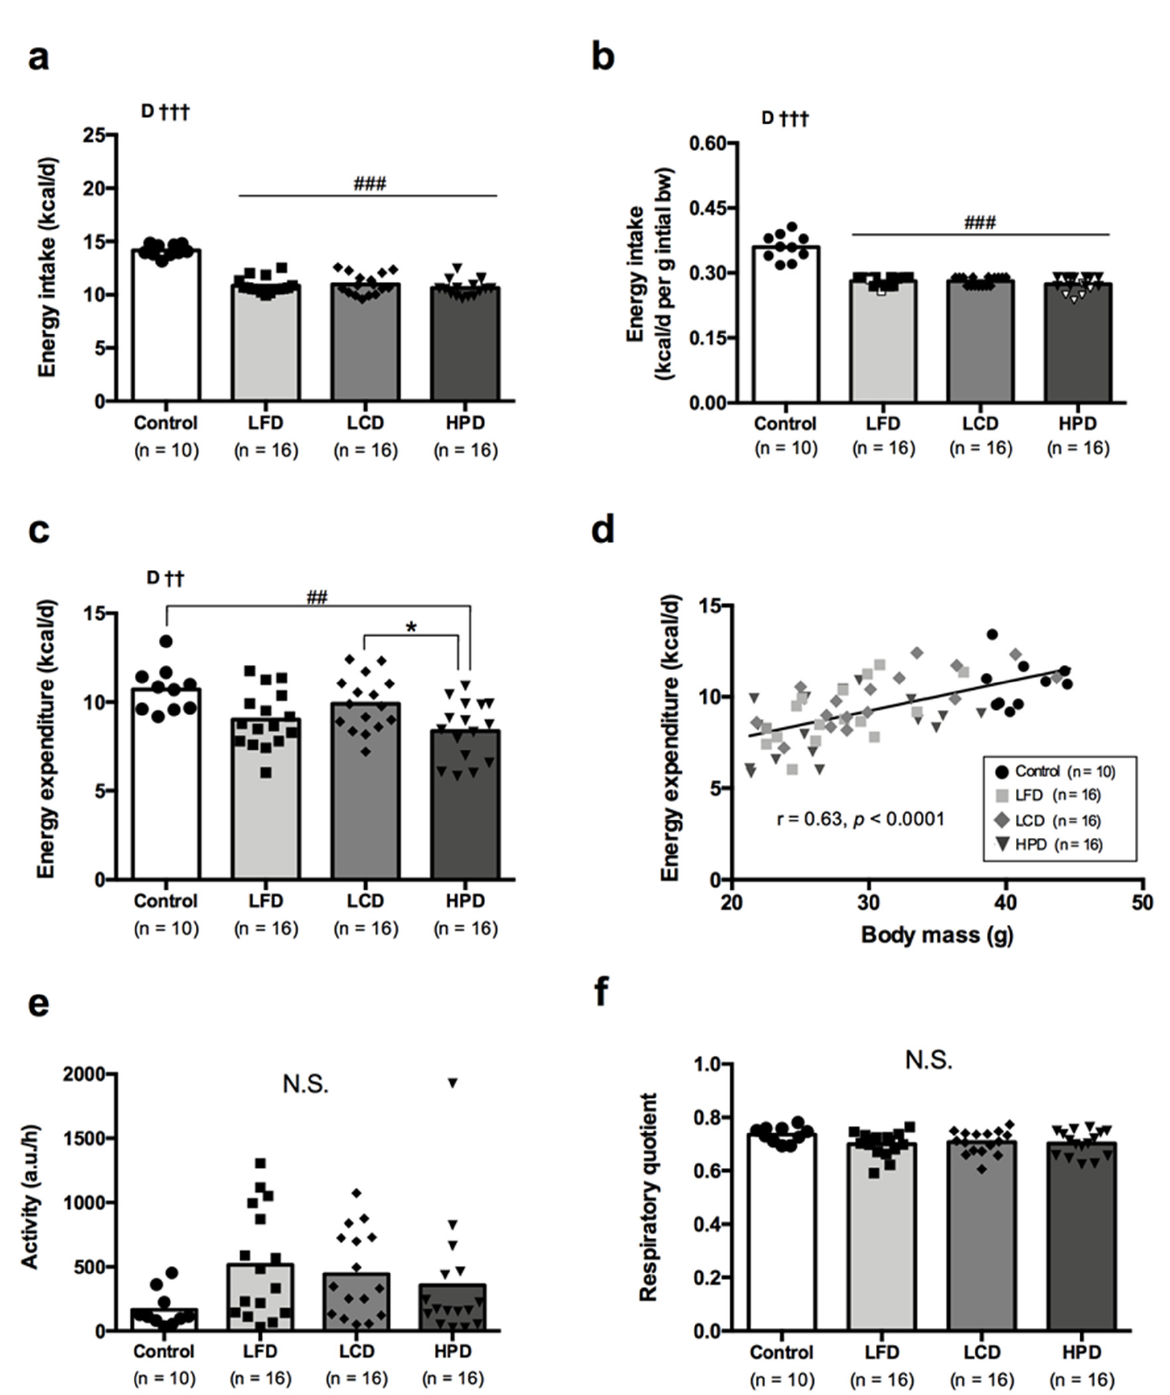
Figure 3. Energy intake ( a , b ), energy expenditure ( c , d ), physical activity level ( e ) and respiratory quotient ( f ) following a 6-week caloric restriction on low-fat (LFD), low-carbohydrate (LCD), high-protein (HPD) diets compared to the age-matched obese controls. Data are means with each dot represents a single mouse (white dots in Figure b indicate mice which had some food leftovers after the final day of CR). Statistical analysis: ( a , c , f ) One-way ANOVA with Bonferroni’s post hoc analysis was performed for diet group effect; ( b , e ) Non-parametric Kruskal-Wallis with Dunn’s post hoc analysis was performed for diet group effect. N.S. indicates no statistical significance between compared means. †† p < 0.01, ††† p < 0.001 for effect of diet group (D). ## p < 0.01, ### p < 0.001 vs. obese controls. * p < 0.05 vs. LCD group.